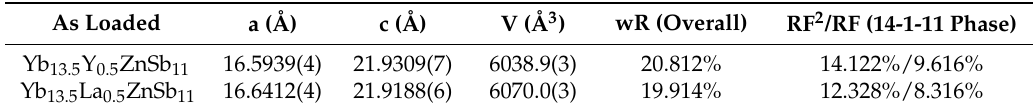
Figure 3. Powder X-ray diffraction (PXRD) patterns of Yb 13.5 Y 0.5 ZnSb 11 (filled in blue) and Yb 13.5 La 0.5 ZnSb 11 (filled in red) from 28° to 37° 2 θ . Unidentified peaks in each pattern are marked by asterisks in respective colors. Table 2. Lattice parameters as determined by refinement of powder X-ray diffraction (PXRD) data using GSAS II.